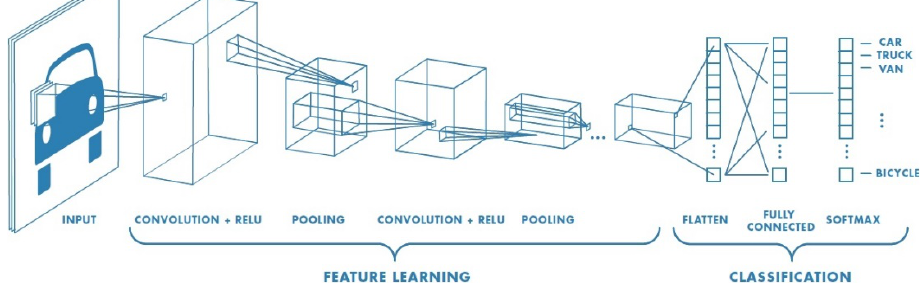
Figure 1: The architecture of a typical CNN. The first few layers usually consist of convolution and pooling layers. Units within the convolutional layers are then organised into feature maps where each unit is connected to local patches of the previous layer though a set of weights known as a filter bank. The result of this weighted sum is passed through a non-linearity (e.g. ReLU or Softmax function). Finally, a fully connected layer is added. The weights of the fully-connected layer are used to determine the classification of the inputted image. [Source: MathWorks.,